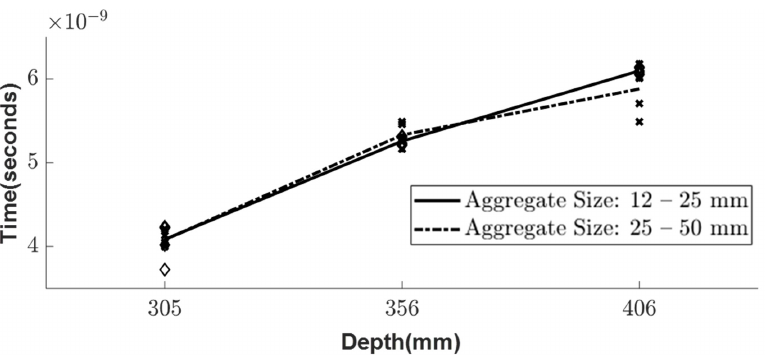
Figure 12. Sca tt er plot of the arrival time in experimental results for two di ff erent sizes of aggre- Figure 12. Scatter plot of the arrival time in experimental results for two different sizes of aggregates. gates .